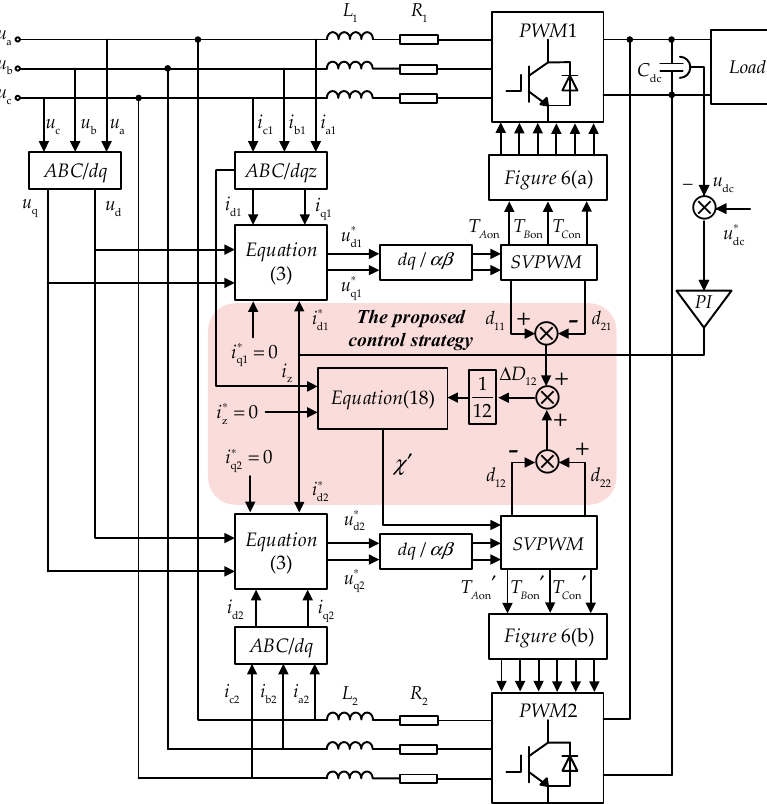
Figure 8. Control system block diagram of paralleled converters.